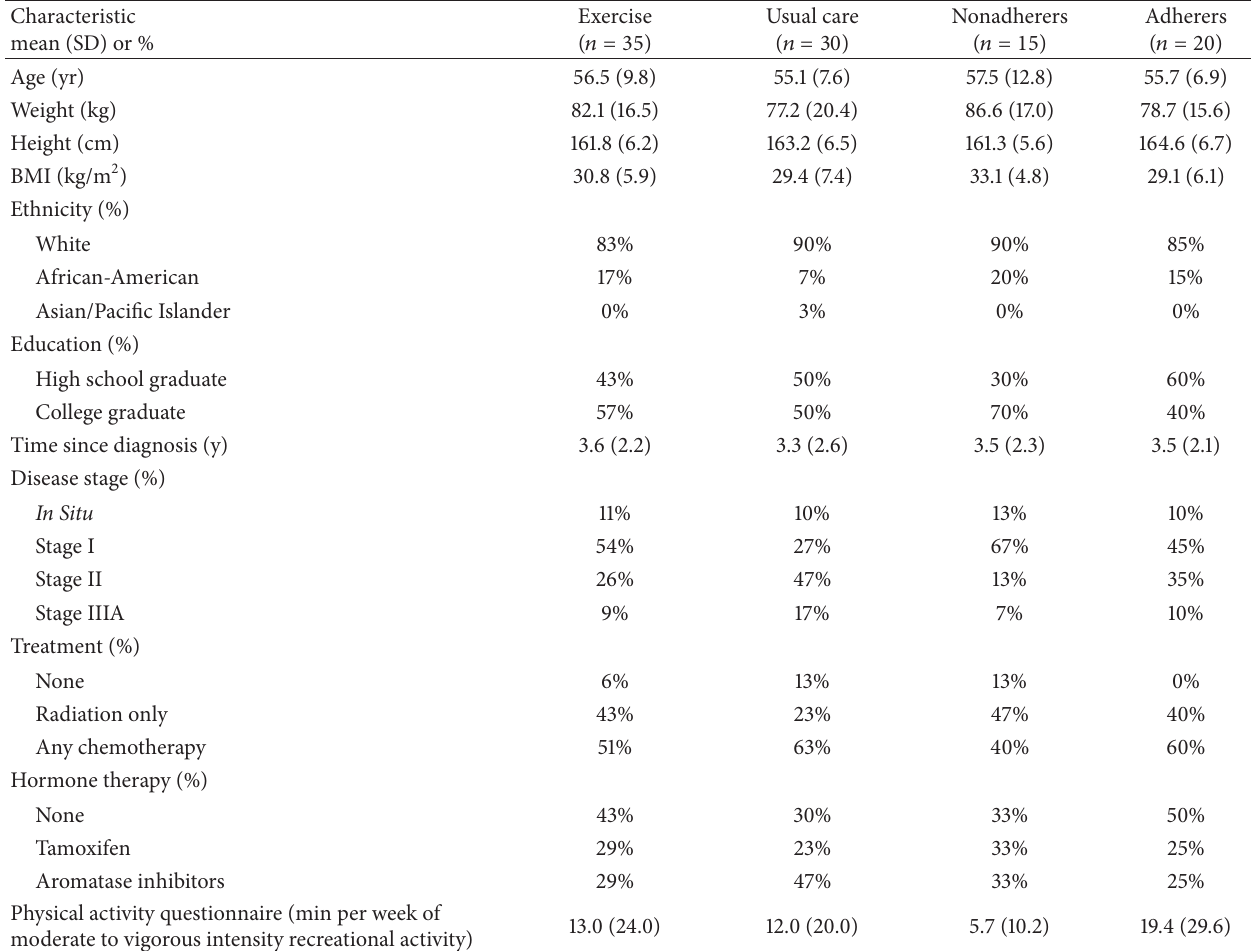
Table 1: Baseline characteristics of participants.